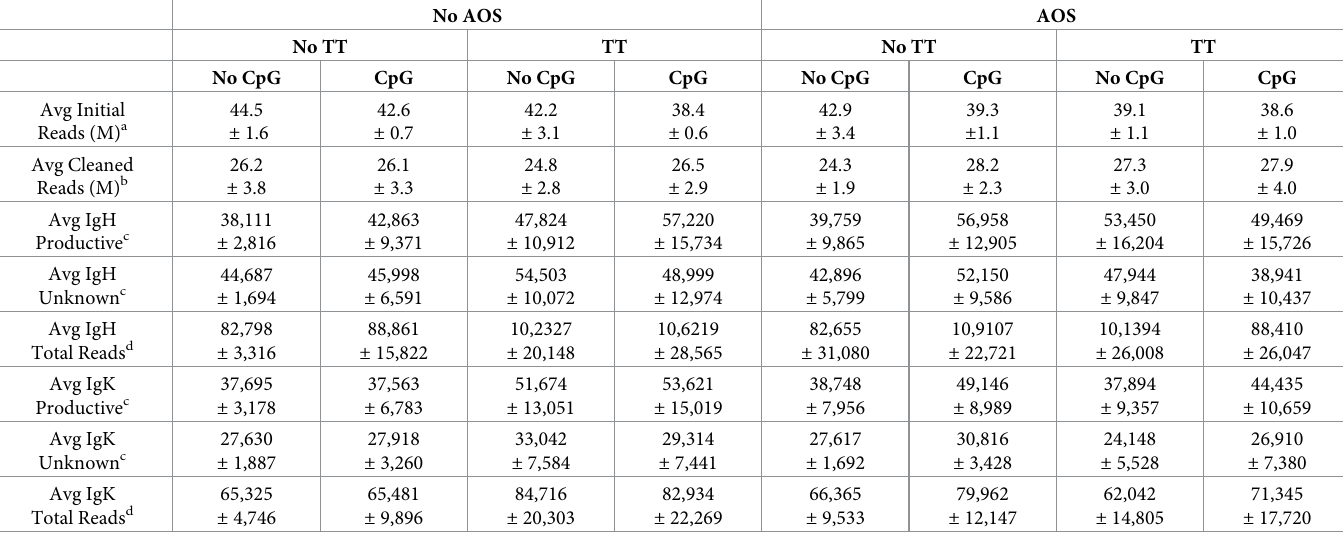
Table 1. Average number of reads obtained per treatment